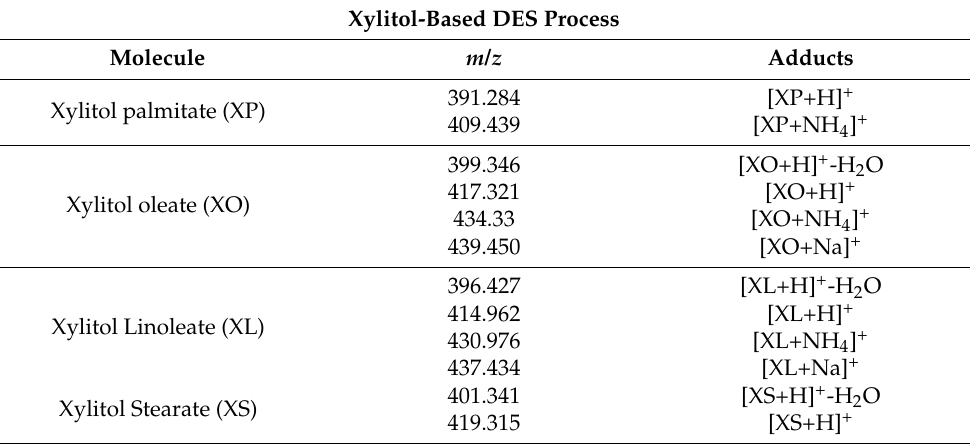
Table A1. Adducts obtained from the ElectronSpray Ionization-Quadrupole (ESI-Q) experiment for each isolated glycolipid